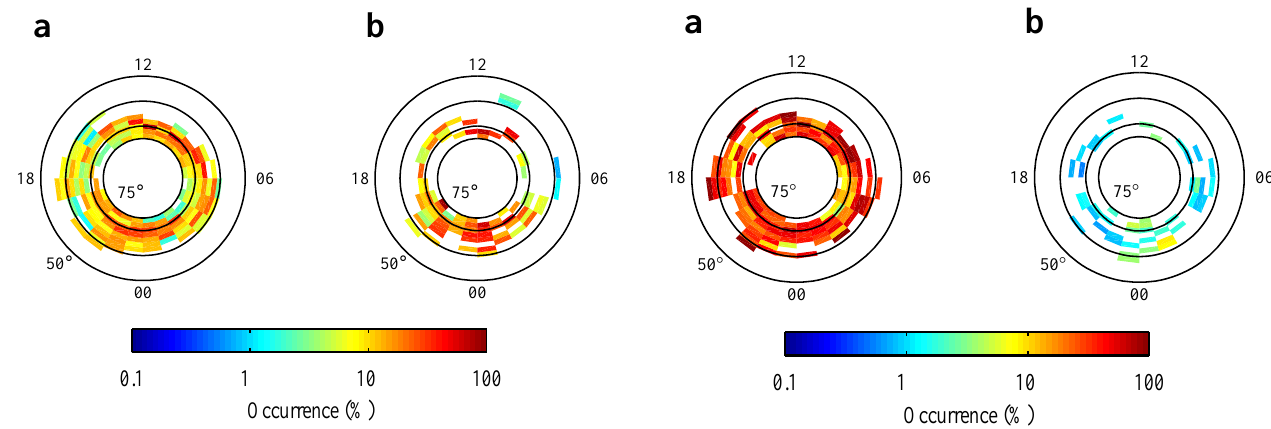
Fig. 2. Probabilities of detecting energized ions versus MLT and INV in the presence of ( a ) BB-ELF waves and ( b ) waves with fre- quencies around the lower hybrid frequency (see Sect. 3 for an exact definition of the waves). The locations of 50 ◦ , 60 ◦ , 70 ◦ , and 75 ◦ INV are indicated with solid lines. The colour scale is the same as in Fig. 1.